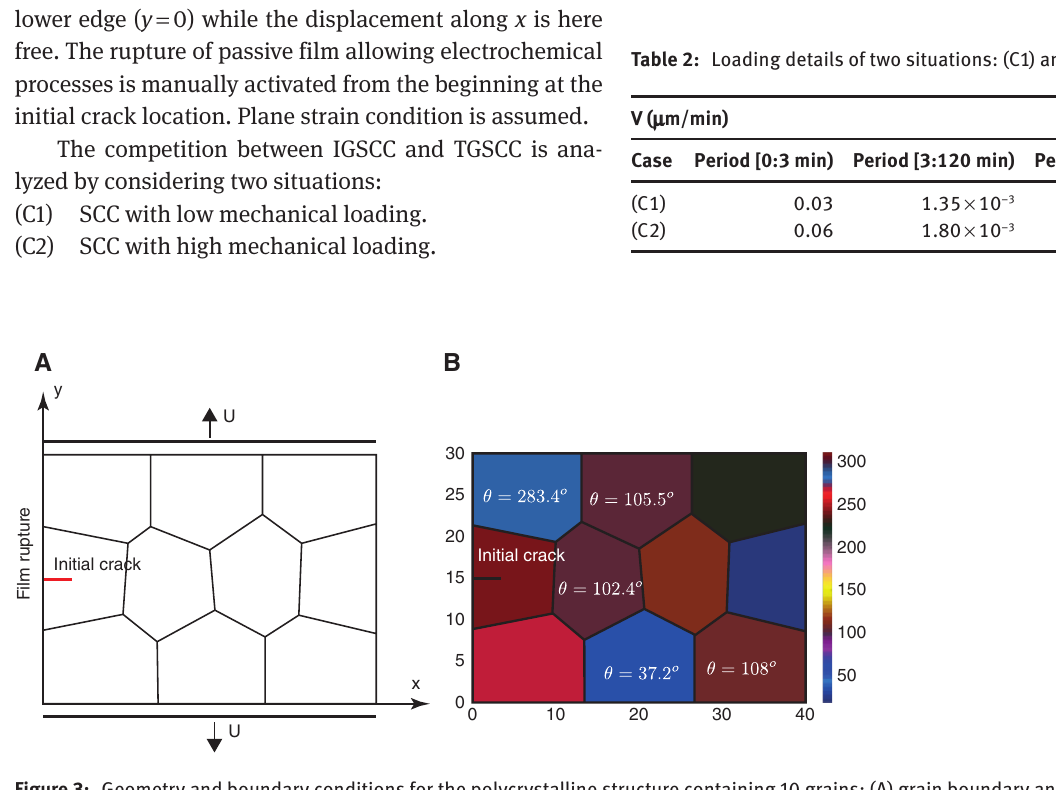
Figure 3: Geometry and boundary conditions for the polycrystalline structure containing 10 grains: (A) grain boundary and loading descrip- tion; (B) description of crystals with angle of the direction of anisotropy.